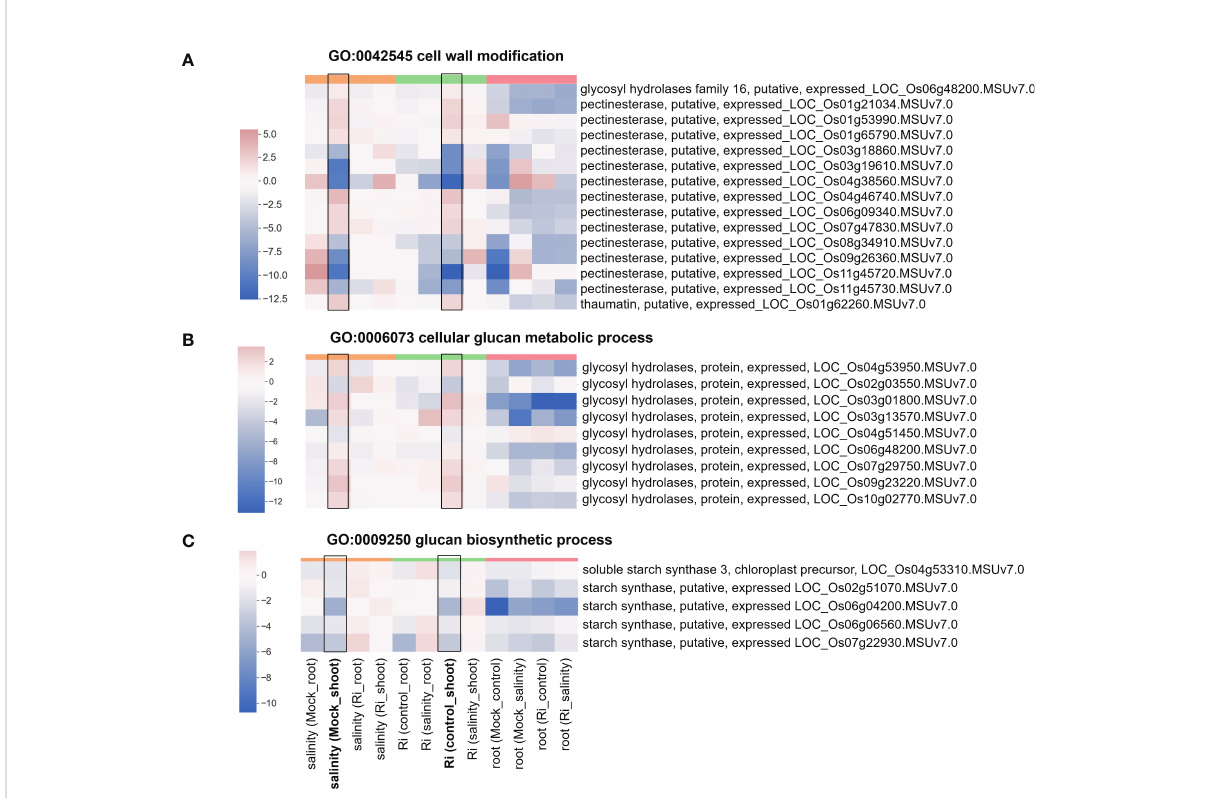
FIGURE 5 Heatmap showing the fold change of DEGs belonging to cell wall-related GO terms (A) Expression pro fi le of DEGs from region 7 with the GO term “ GO:0042545 cell wall modi fi cation ” . (B) Expression pro fi le of DEGs from region 7 with the GO term “ GO:0006073 cellular glucan metabolic process ” . (C) Expression pro fi le of DEGs from region 7 with the GO term “ GO:0009250 glucan biosynthetic process ” . The log2(fold change) values of DEGs from the selected GO terms were visualized with a heatmap. The color bar on top of the heatmap indicates the DE comparison groups: orange – salinity effect; green – AM symbiosis; pink – tissue difference. On the x-axis, each column represents a pairwise comparison to show the effect causing the DE, and inside the parentheses are the